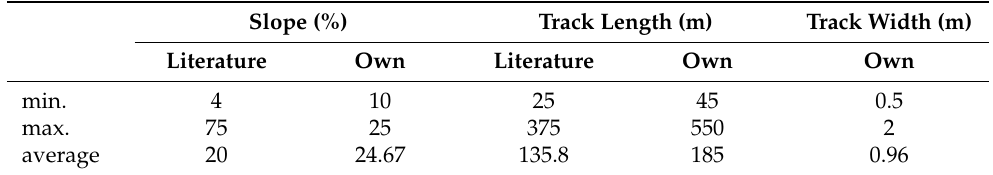
Table 3. Factors that determine the work productivity of horse logging. Track means the route where the horse drags the log from its harvesting place to the location for transport. Slope (%) Track Length (m) Track Width (m) Literature Own Literature Own